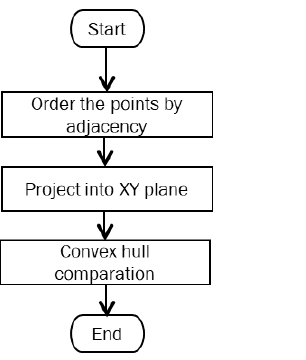
Figure 2. Counterclockwise ordering algorithm flow chart.